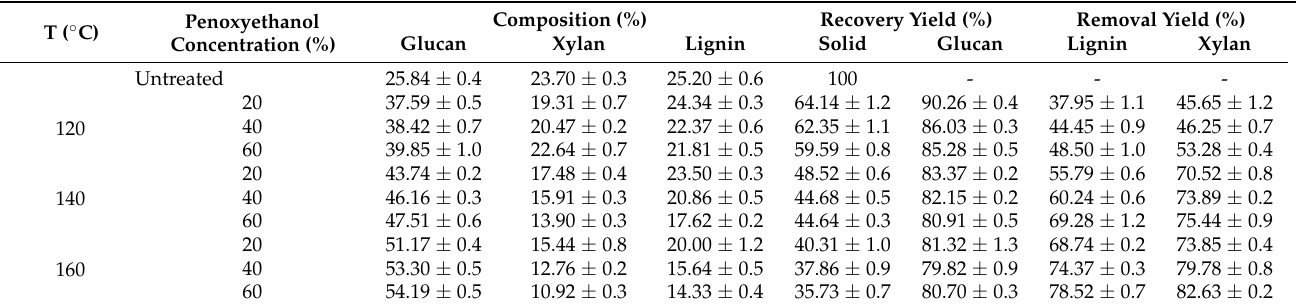
Table 1. Pretreatment yield and compositions change of